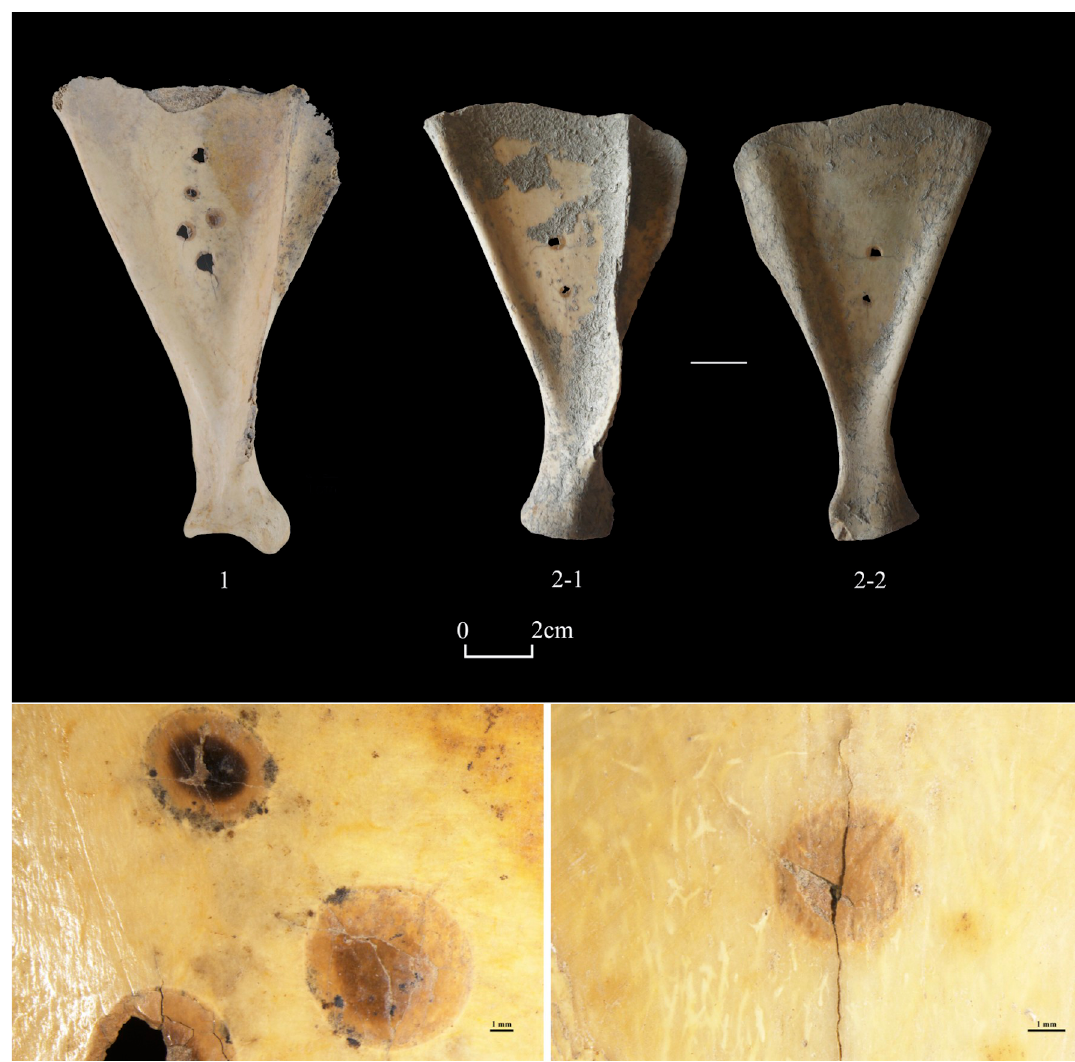
Fig 4. Examples of oracle bones from Shirenzigou. 1) specimen from 2009HBSIIIT0822 ④ ; 2) specimen from 12XBSIIIT0720II-3 ④ . The close-ups at the bottom show brownish burned marks on the scapulae (Left: specimen from 2009HBSIIIT0822 ④ ; Right: specimen from